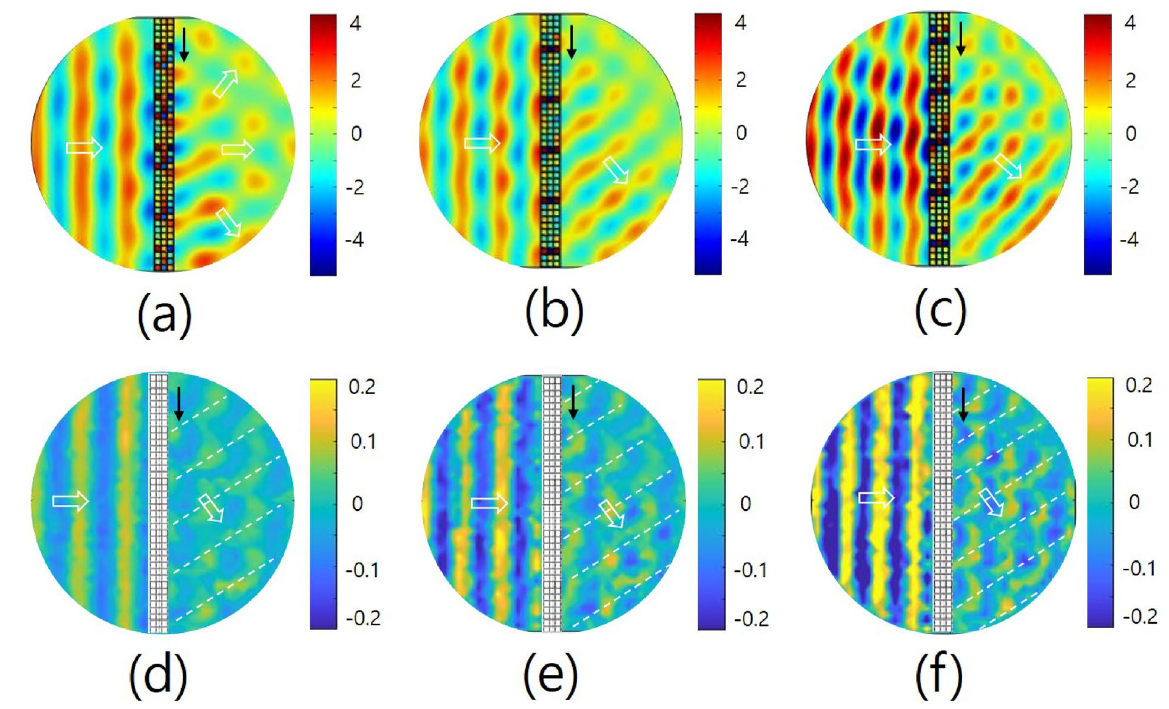
Figure 5. The propagation of sound waves after passing through the metasurface with respect to the frequencies at normal incidence. ( a – c ) are the results of the numerical simulation, and ( d – f ) are the corresponding results of the experimental measurement. The white arrows are the propagation directions of sound waves incident and after transmission, and the black arrow near the metasurface indicates the increment direction of the effective refractive index of the metasurface. The driving frequencies of figures ( a )–( c ) are 1700, 2000 and 2300 Hz, respectively. The experimental (theoretical) values of the refractive angles are approximately − 55 ◦ ( − 65.0 ◦ ) , − 48 ◦ ( − 50.4 ◦ ) and − 46 ◦ ( − 42.0 ◦ ) , where we set the sign of the angle to be positive when the angle is counterclockwise from the